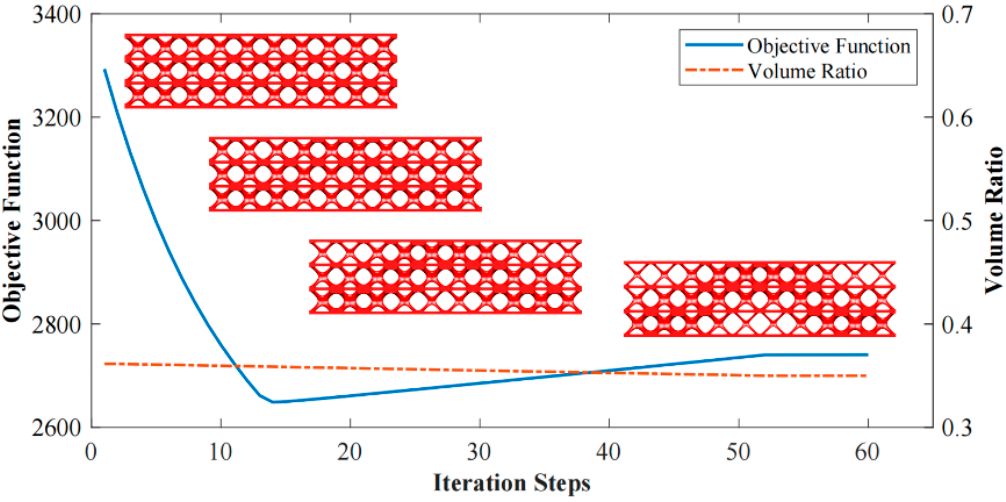
Figure 18. Interaction history of 3D LSS design.